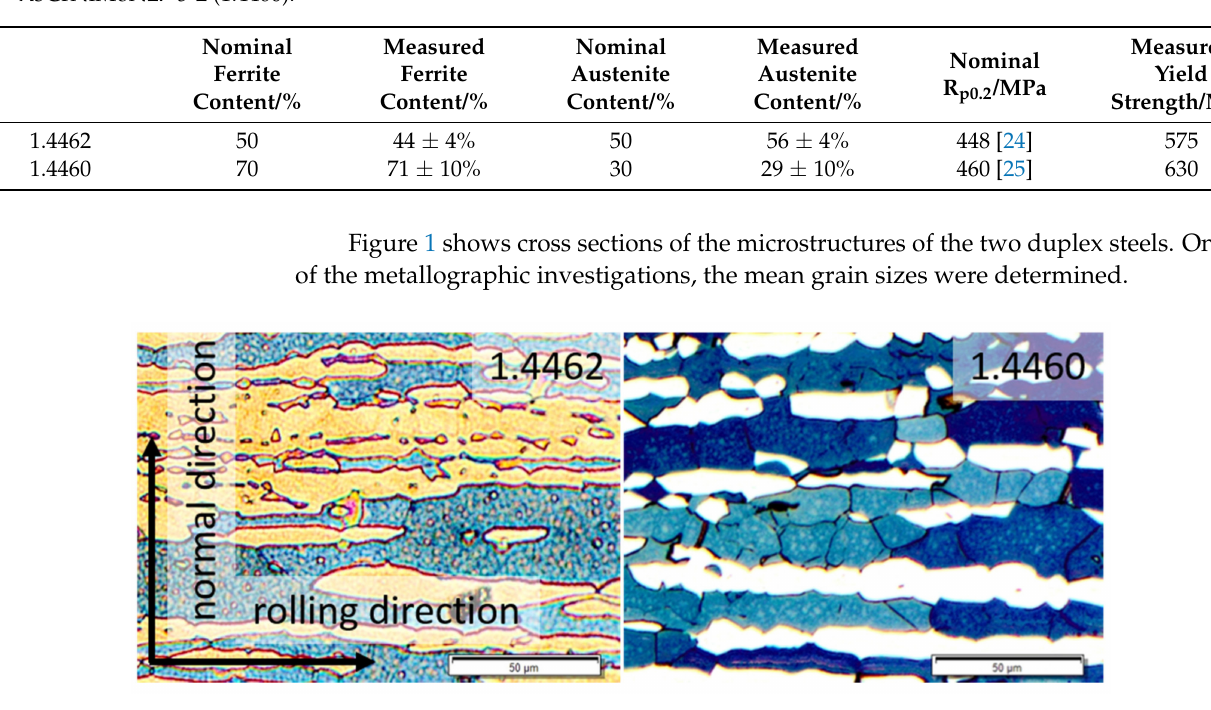
Figure 1. Cross sectional views of the microstructure of duplex steels X2CrNiMoN22-5-3 (1.4462) and X3CrNiMoN27-5-2 (1.4460) in the initial state (in the centre of the plate). Etchant: Beraha II; bright regions: austenite; dark regions: ferrite. The directions of the plate coincides with the subsequent deep rolling